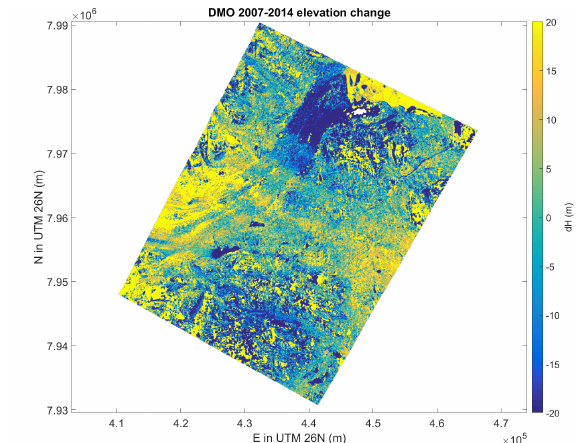
Figure 9: Measured elevation change from co-registered 2007 and 2014 SPIRIT DEMs.